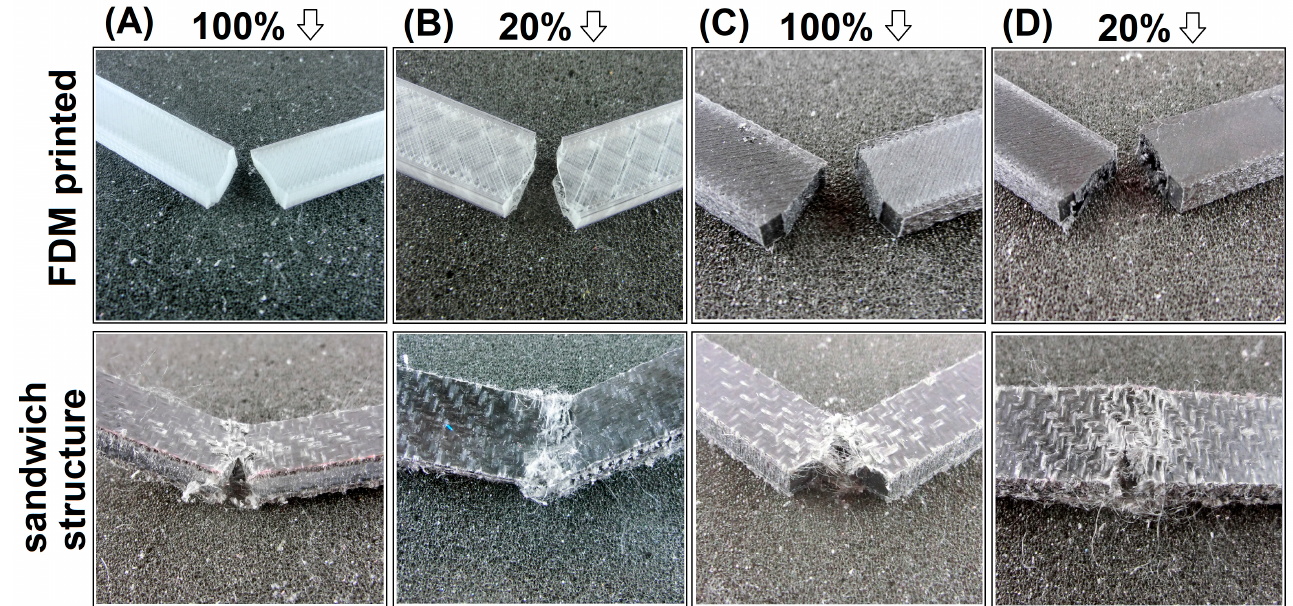
Figure 7. The appearance of the notched samples after the test. The picture at the top presents the FDM-printed specimen, while sandwich samples are at the bottom: ( A ) pure GPET–100% infill, ( B ) pure GPET–20% infill, ( C ) GPET/CF–100% infill, and ( D ) GPET/CF–20% infill.